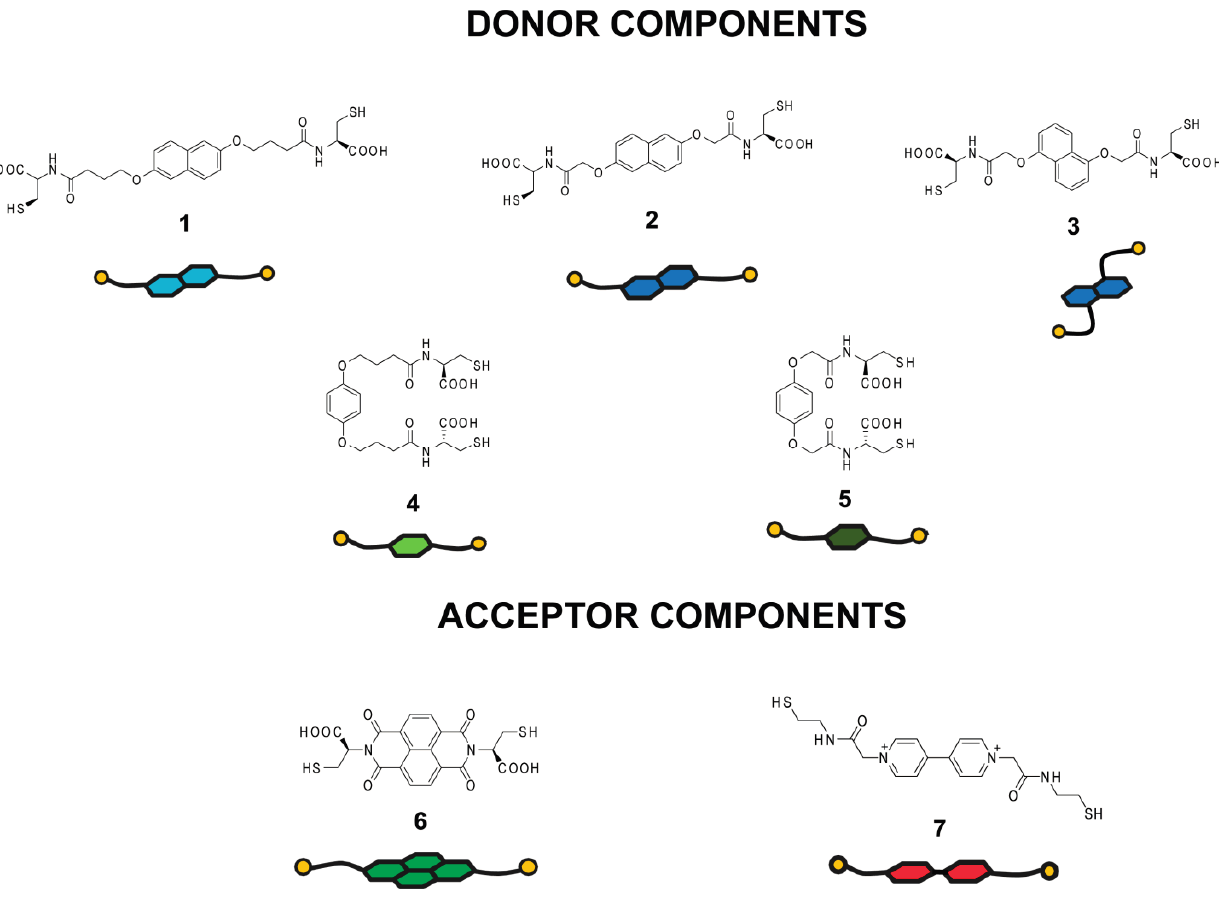
Figure 1. Structures and schematic representations of the thiol-functionalized components employed in the generation of a dynamic combinatorial library (DCL) in